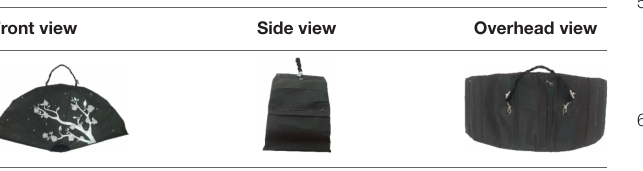
TABLE 4 | The first finished product of “winter flowers” by student A.